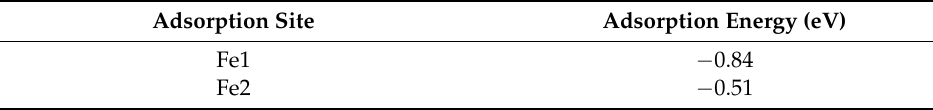
Table 3. HCl adsorption energy on Fe 2 SiO 4